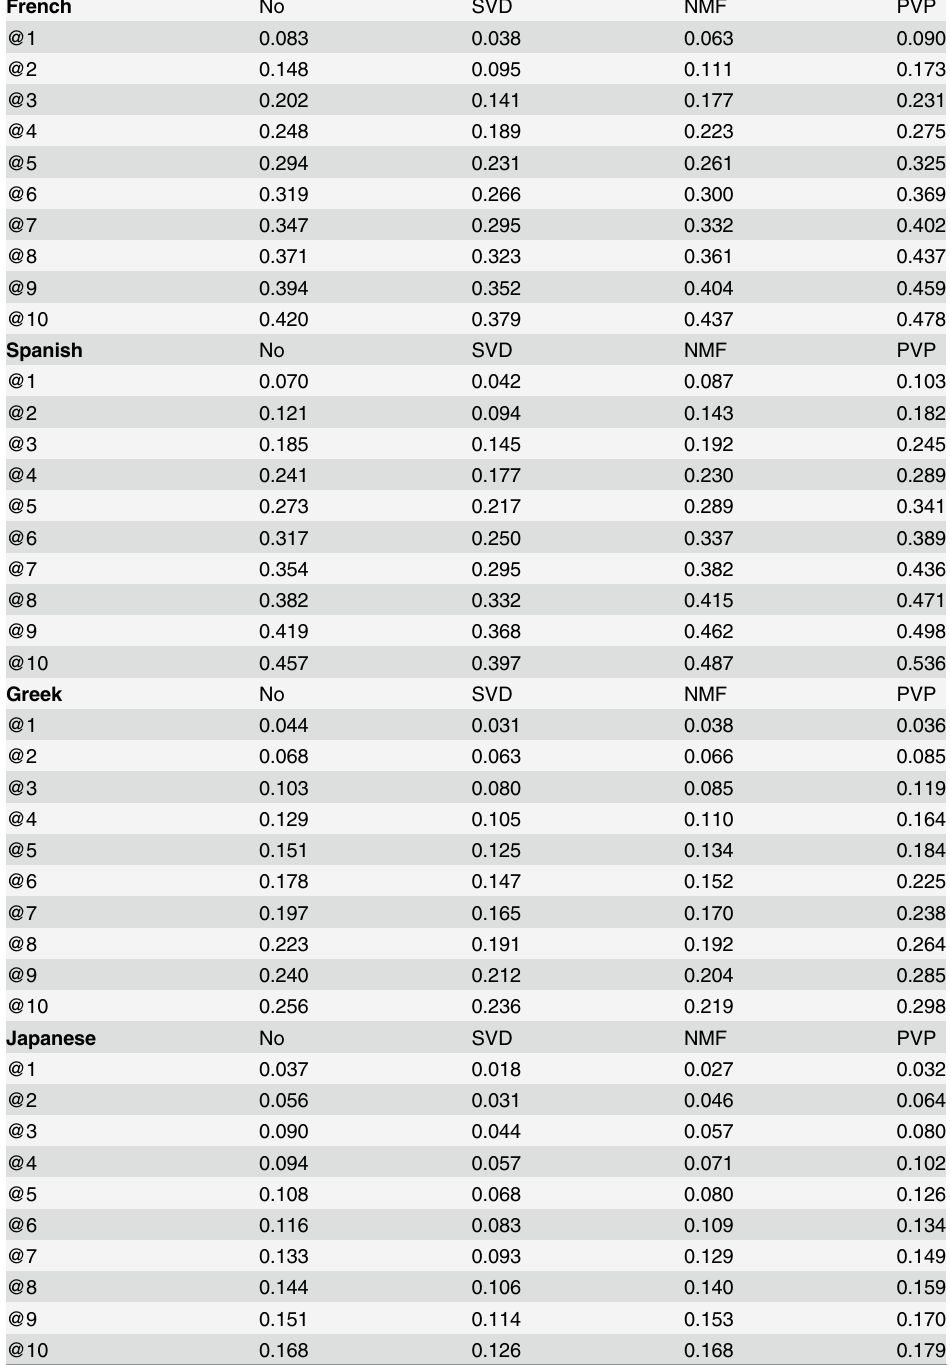
Table 4. Precision@rank values for English as the source language and different target languages using contextual